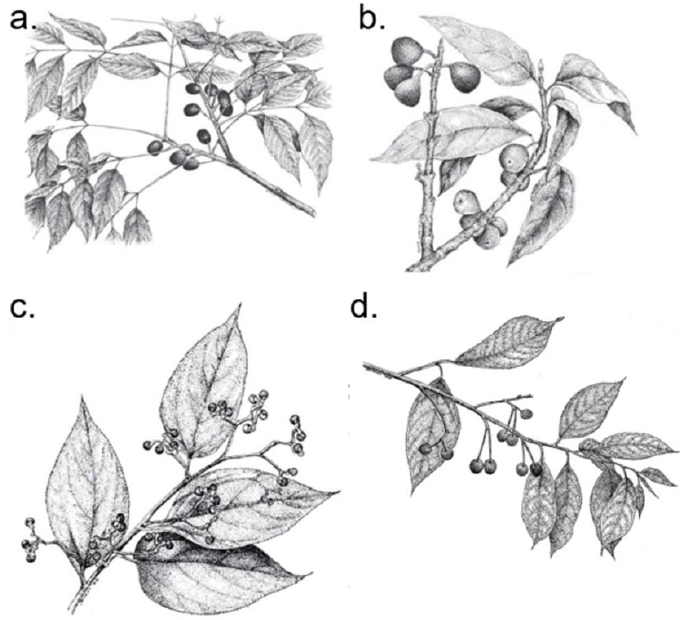
Figure 2. Foliage and fruit of four studied species: ( a ) Choerospondias axillaris (Roxb.) B.L. Burtt and A.W. Hill, ( b ) Ficus hispida L.f., ( c ) Hovenia dulcis Thunb., and ( d ) Prunus cerasoides Buch.-Ham. ex D. Don.